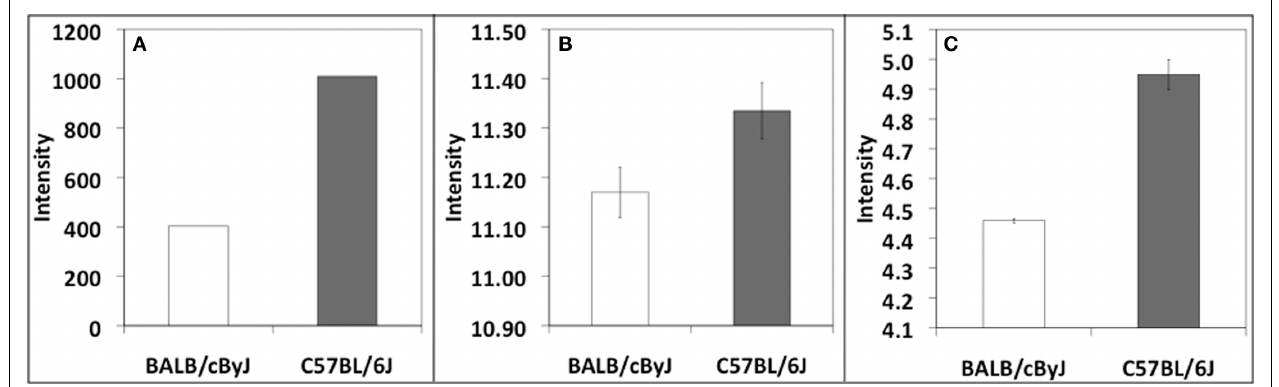
are available at http://webqtl.org, accessions GN123, GN273, respectively.The Wiltshire et al. data utilized the Affymetrix 430 v2 array.TheWilliams et al. data utilized the Affymetrix Mouse Exon 1.0 ST Array.The 3 (cid:2) UTR probeset from the Exon 1.0 ST Array was utilized for comparison